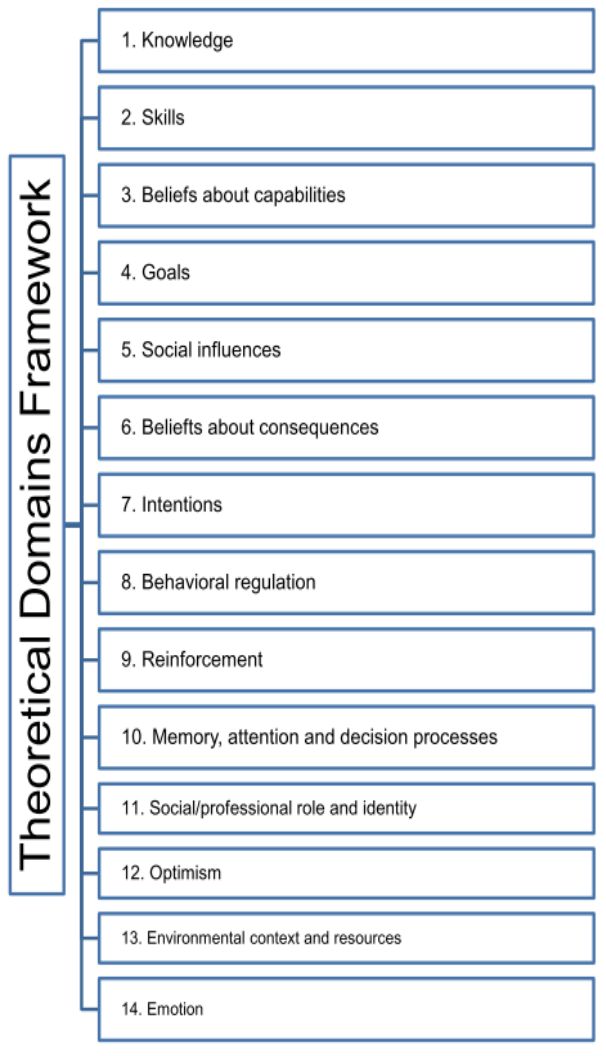
Figure A1. The 14 Domains of TDF.